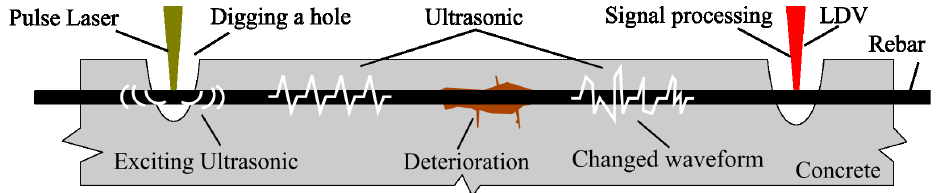
Figure 2. Concept of the corrosion detection method for the reinforced concrete structures at the Fukushima Daiichi Nuclear Power Plant (NPP) de-commissioning site.